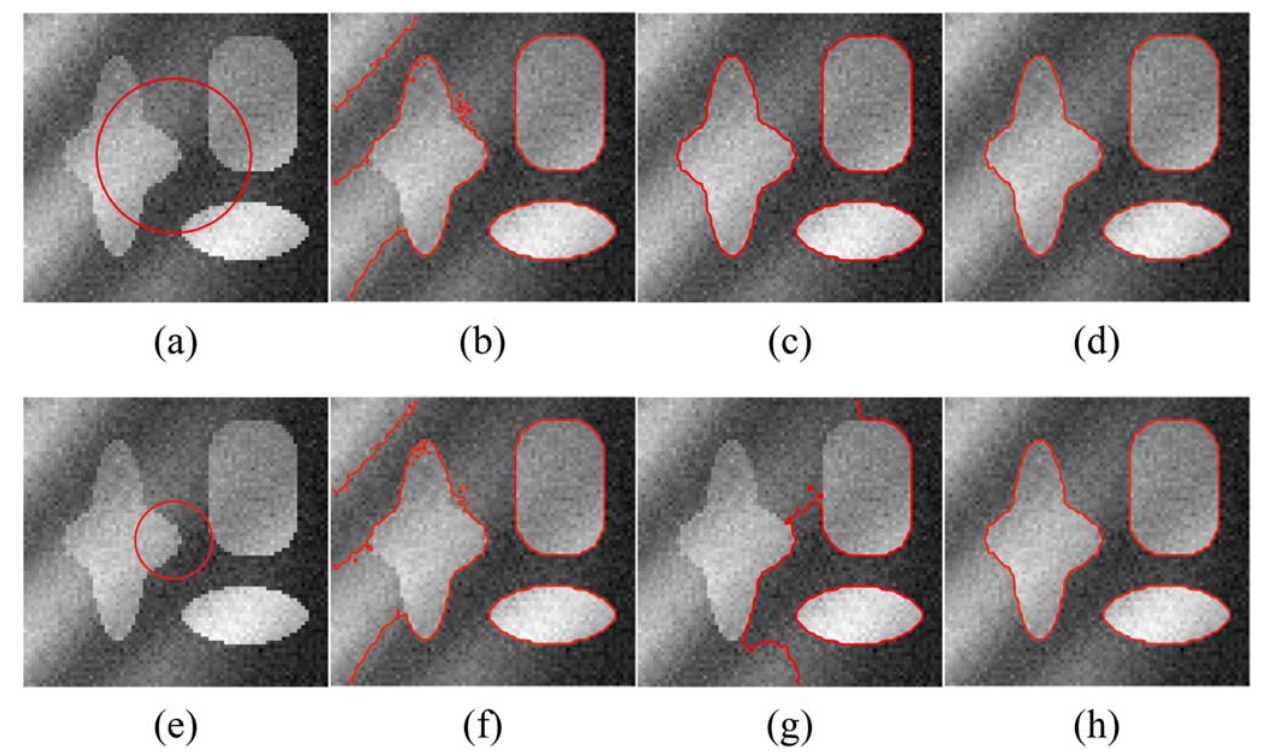
Fig 6. Comparisons of the segmentation results for a synthetic image with intensity inhomogeneity between Li ’ s model, LSACM and our model. (a), (e) The original image with red initial contours. (b), (f) The results of Li ’ s model. (c), (g) The results of LSACM. (d), (h) The results of our